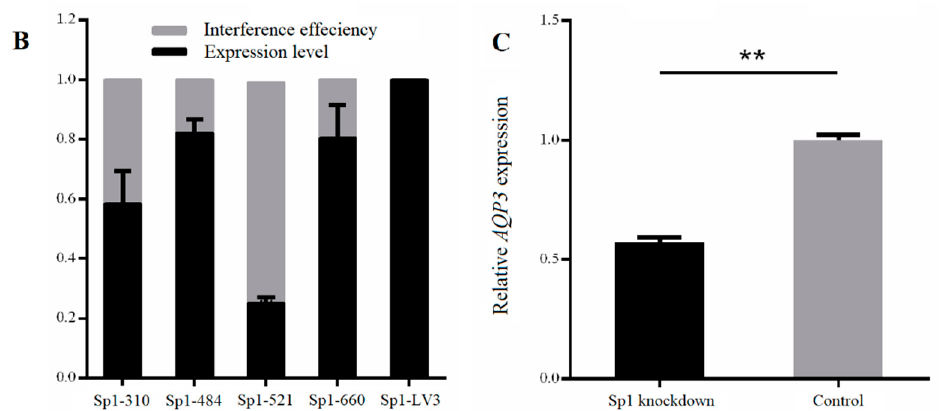
Figure 6. The expression of Sp1 and AQP3 genes in IPEC-J2 cells after Sp1 knockdown. (A): The white and fluorescence microscope pictures of IPEC-J2 cells transfected respectively with the four Sp1-interfering shRNAs and the control shRNA, represented as Sp1-310, Sp1-484, Sp1-521, Sp1-660, and Sp1-LV3 (200×); (B): The interference efficiency of four Sp1-interfering shRNAs; (C): The expression of AQP3 gene in IPEC-J2 cells transfected with Sp1-521 shRNA. **, p <0.01.